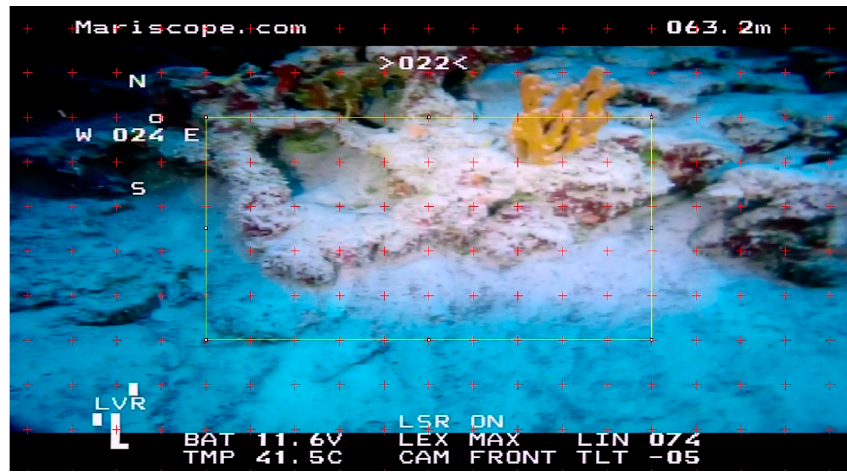
Figure 3. Quadrant of 1 m × 0.5 m established at the center of grid on the still images, which enclose 66 grid–points used for estimations of benthic coverage and OTUs abundance. To enable the listing of the different objects seen in the quadrats (>1 cm), an initial classification in OTUs (Operational Taxonomic Units) according to growth forms (erect, encrusting) and main taxonomic groups (octocorals, black corals, sponges) was done. identification until the lowest possible taxonomic level.